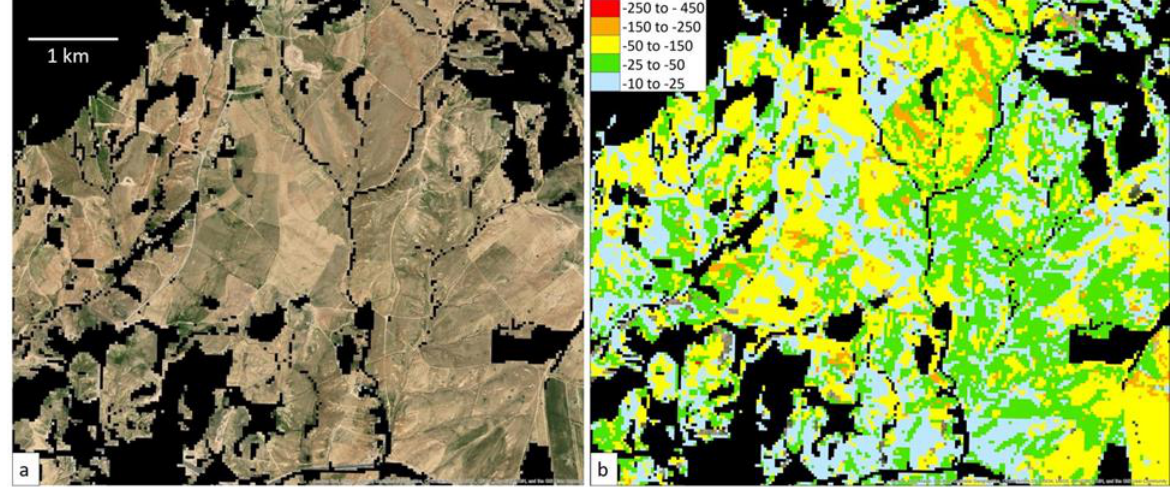
Figure 9. Bedouin Cultivation showing small fields and noncultivated patches, 5 km NW of Kuseife (31°16.89’ N, 35°4.96’ E). ( a ) True color image with settlements masked; ( b ) LNS diff (gC m −2 yr −1 ).